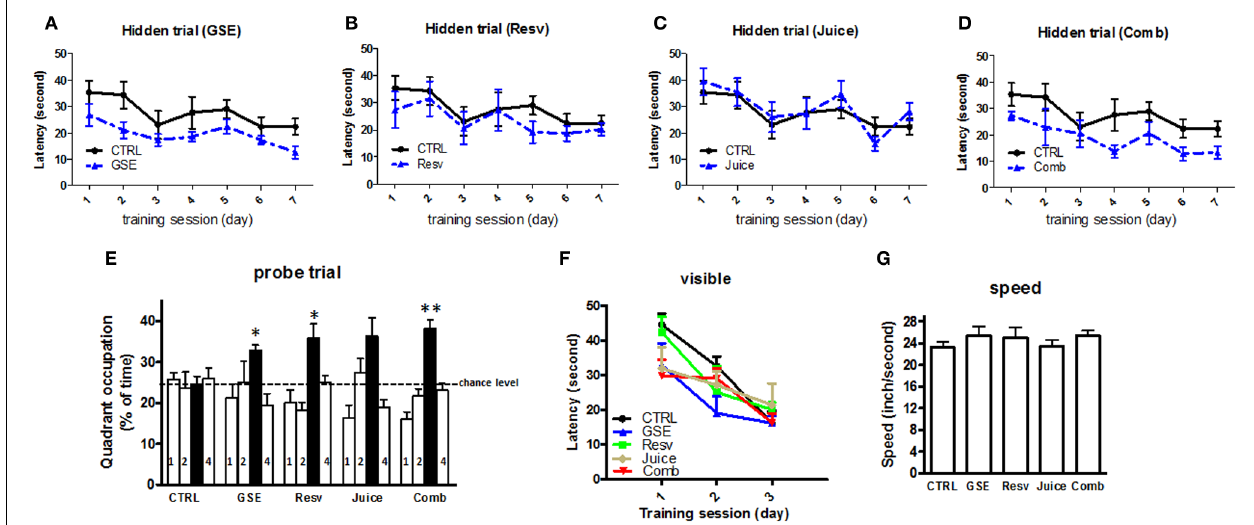
Spatial memory retention in the probe trial: percent of time in quadrant is calculated as the ratio of time spent in the target quadrant area relative to the time spent in the rest of the pool (quadrants: : target; 1-left; 2: opposite; 4: right) (F) Cued platform visible trial (G) Average swimming speed. Data represents mean ± s.e.m. n = 7 − 9 per group.